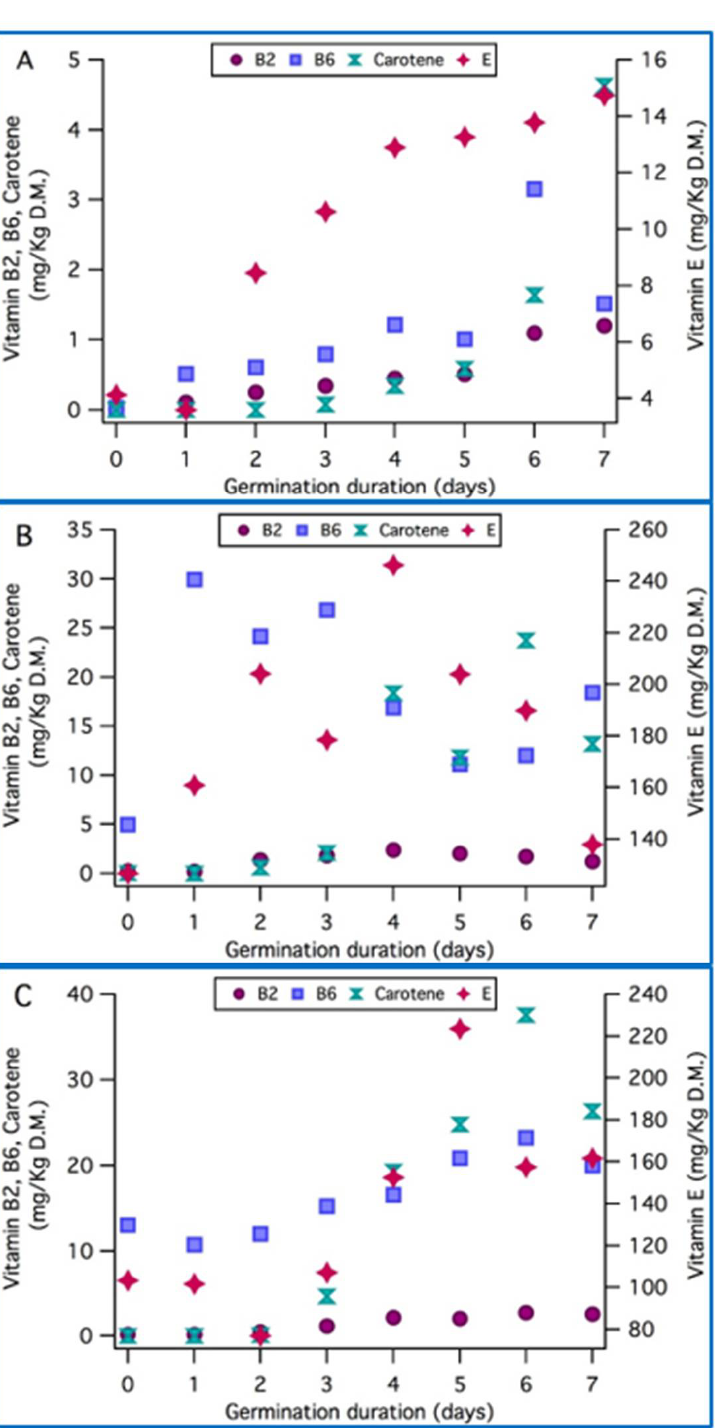
Figure 4. Vitamin B2, vitamin B6, vitamin E, and β-carotene kinetics throughout germination of wheat ( A ), alfalfa ( B ), and radish ( C ) seeds and sprouts, expressed as mg/g DM of seeds. Radish and alfalfa sprouts showed remarkably higher levels of vitamins than wheat shoots, especially for vitamin E. α-tocopherol levels reached 246.2 mg/kg and 223.5 mg/kg in the radish and alfalfa sprouts, respectively, followed by the wheat sprouts (14.7 mg/kg). Accordingly, it is interesting to consider the consumption of radish and alfalfa sprouts, since their vitamin E content is closely comparable to that of almonds (240 mg/kg accord- ing to the USDA), one of the richest sources of α-tocopherol. In general, an optimal vitamin content will be reached after 7, 6, and 4 days of germi- nation for the wheat, radish, and alfalfa seeds, respectively. Contrasting the vitamins con- tents of sprouts at their respective optimal day of germination (7 for wheat, 4 for the al- falfa, and 6 for radish) to the Recommended Dietary Allowances (RDAs) of vitamins as